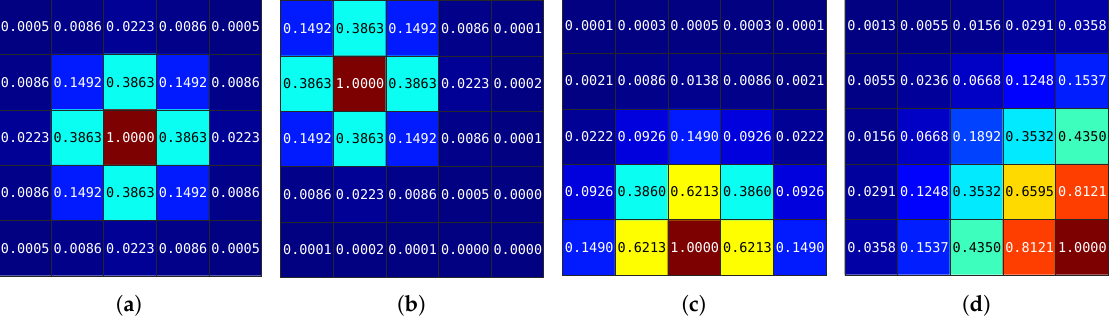
Figure 2. Distribution of normalized irradiance profile model for a 5 × 5 PV array: highest irradiance cell is located at ( a ) center, ( b ) upper left side, ( c ) bottom center side, and ( d ) bottom right side. Table 1. Four experimental setups to validate a mathematical